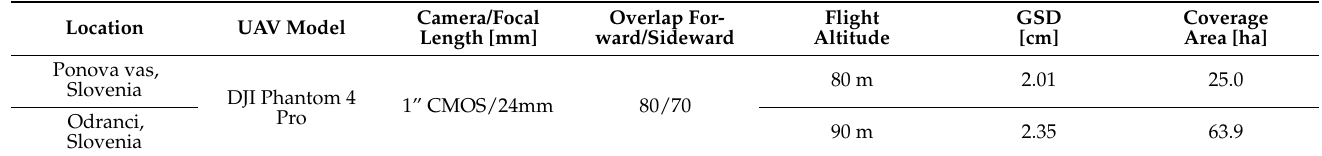
Table 1. Specification of the unmanned aerial vehicle (UAV) dataset for the selected study areas.